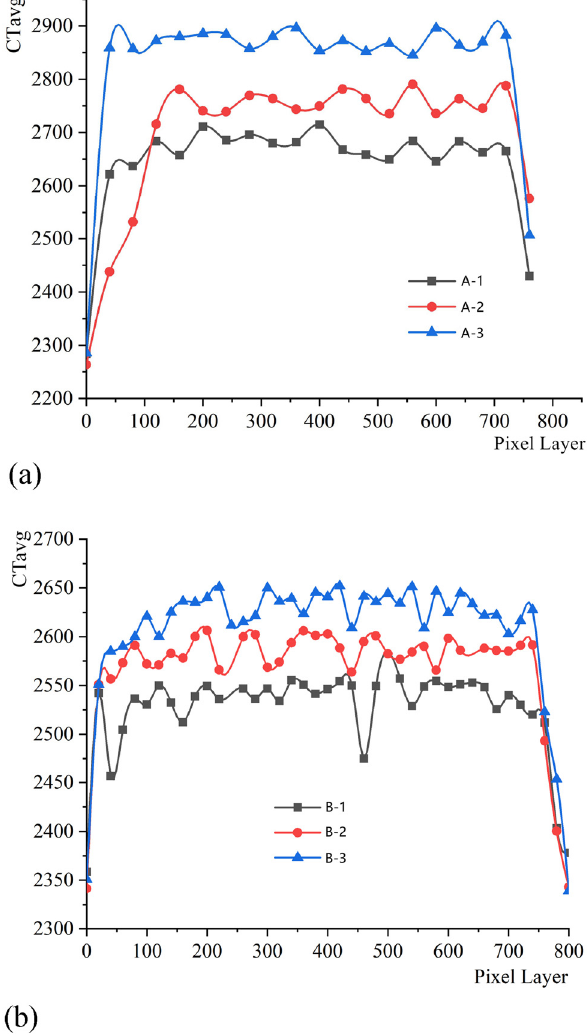
Figure 6: CT digital scan under di ff erent experimental conditions. ( a ) Conventional triaxial test and ( b ) triaxial compression test with step